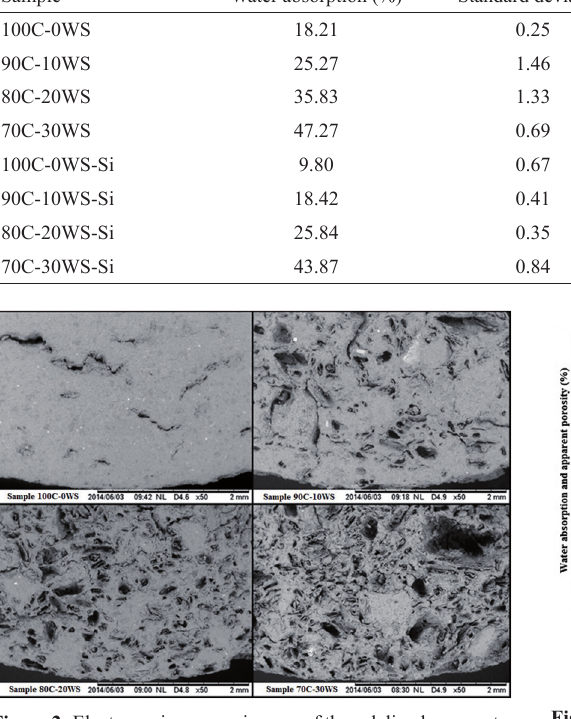
Figure 2: Electron microscopy images of the calclined aggregates made with different amount of wood sawdust.